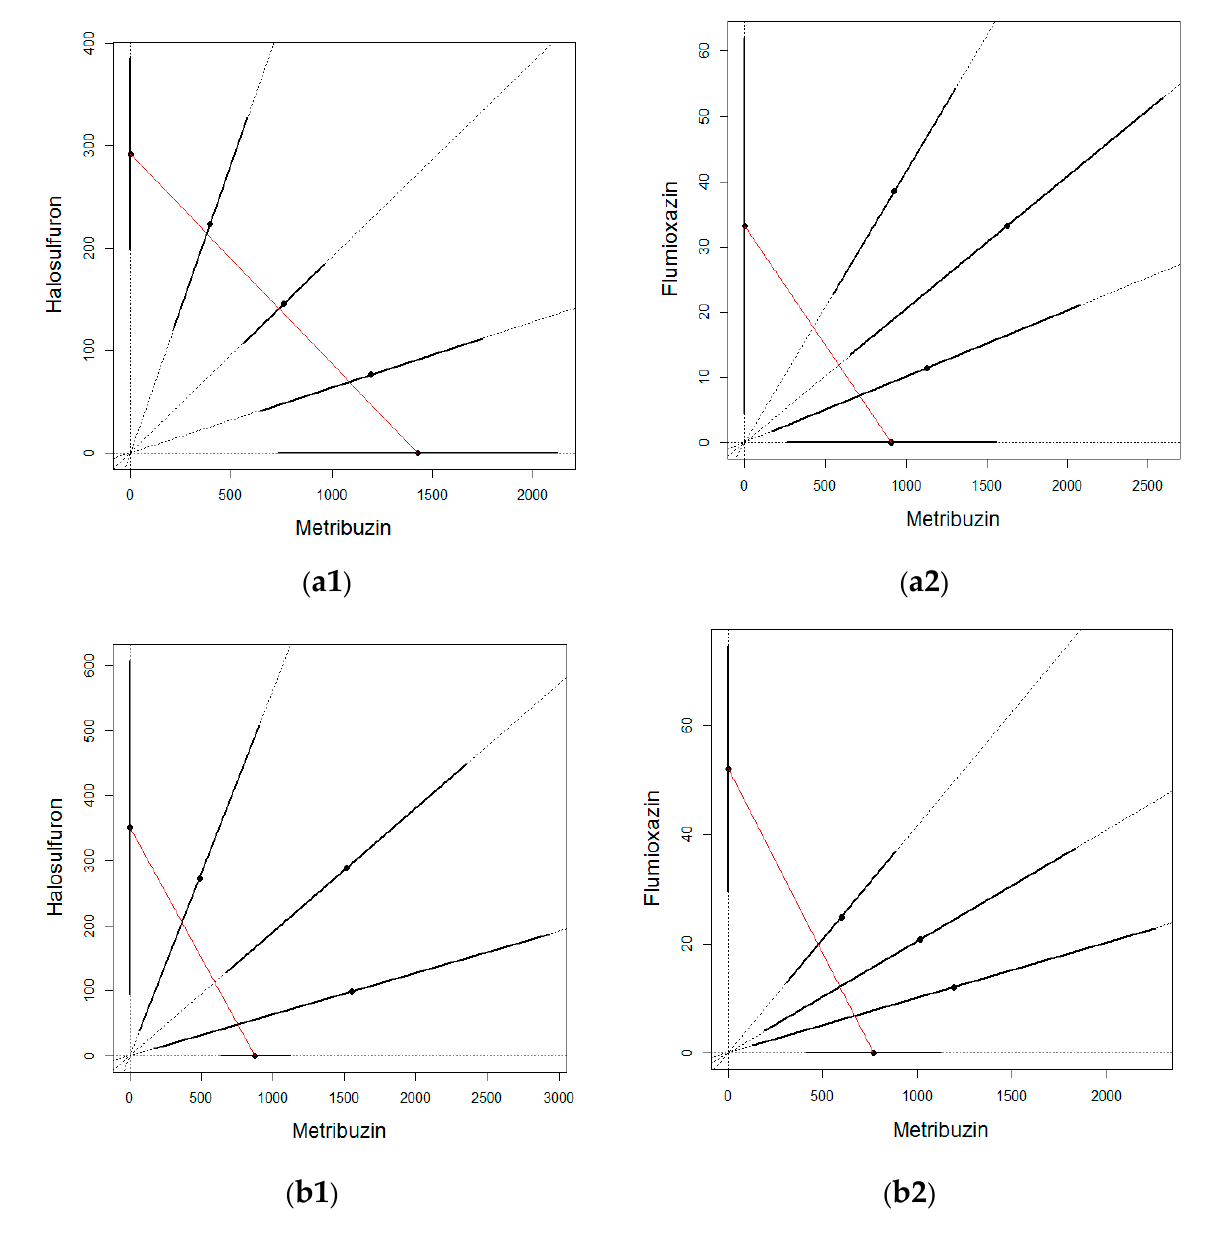
Figure 4. ED 50 isobologram showing the interactions of metribuzin:halosulfuron on F v /F m of potato in 4 h ( 1 ) and 8 h ( 2 ) in the first ( a ) and second experiment ( b ). The straight line of isobologram indicates additivity. The lines around the mixture points are 95% confidence intervals .